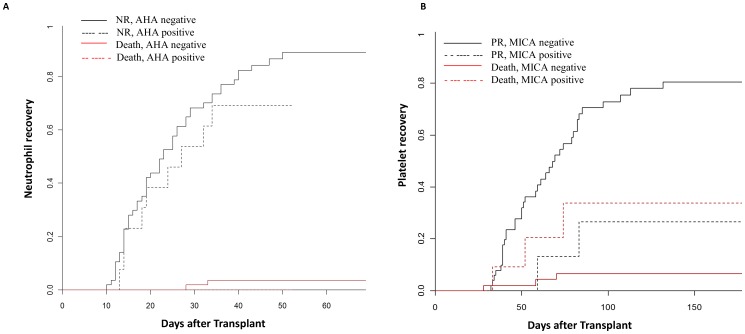
Cumulative incidence of neutrophil and platelets recovery.A) 69.3% (95%CI: 58.49–80.11%) of patients positive for both class I and II anti HLA antibodies (AHA) had neutrophil recovery (NR) compared to 89.3% of negative patients (95% CI: 82.06–96.54%). NR did not differed in both groups, Gray’s test p-value = 0.21, hazards ratio is 1.6 (0.8–3.3). No patients detected for both class AHA were dead before NR. B) Patient’s positive for anti major-histocompatibility-complex class I–related chain A antigen (MICA) antibodies had lower cumulative incidences of platelet recovery (PR, 26.5% (95% CI: 15.51–37.49%) compared to negative patients (80.5%; 95% CI: 70.64–90.36%).Total number of patients included in analysis was 62; death before PR was used as competing event, and for 8 patients we do not have conclusive MICA status. Gray’s test p value = 0.04, hazards ratio is 4.3 (1.02–17.8).